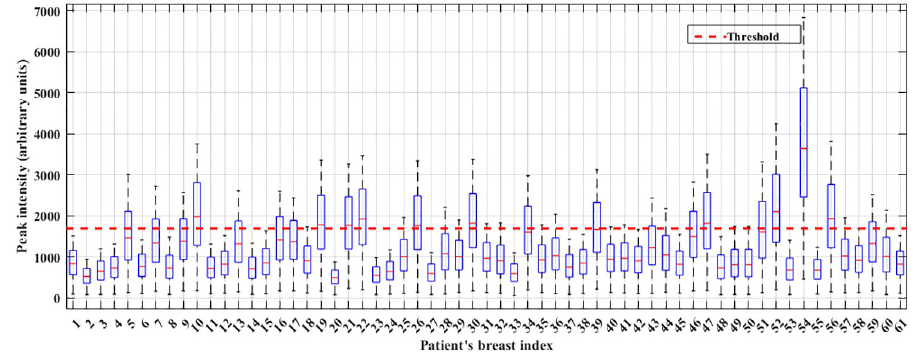
Fig 7. Box whisker plot for the examined breast images with the thresholding. 61 breasts’ data have been filtered through Gaussian kernel to decide the threshold value, where the x -axis represent the number of breasts’ index and y - axis represent the peak intensity (arbitrary units) of each